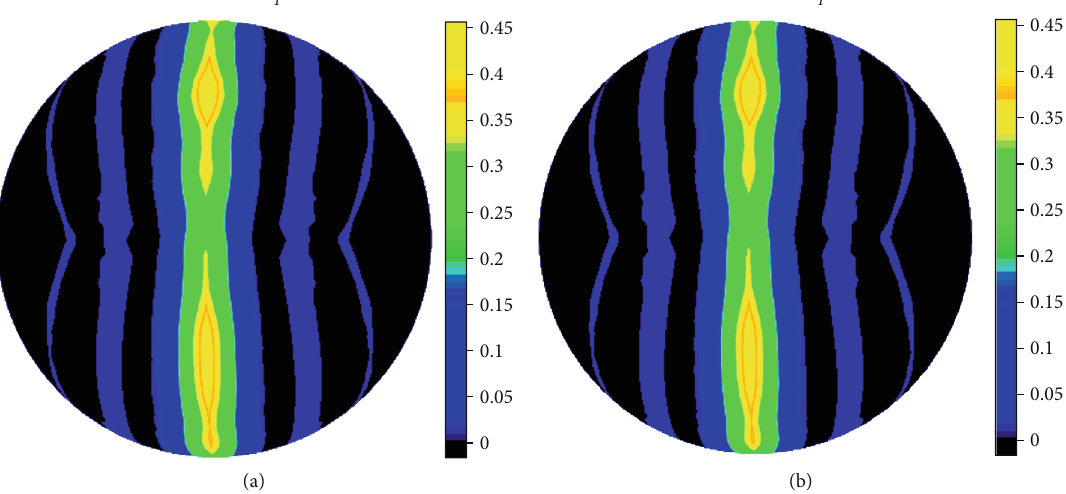
= 0 : 000026 , D = 0 : 000182 , T = 100 , and k = 0 : 45 u v